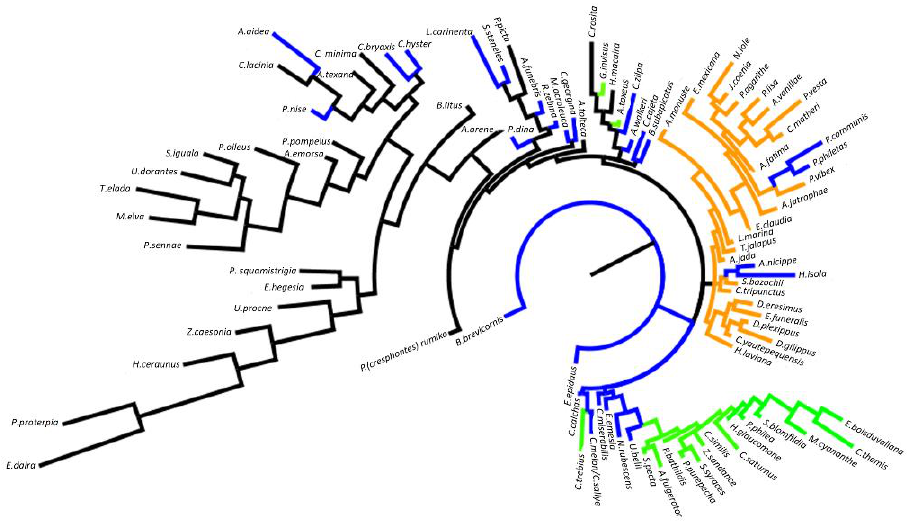
Figure 4. Cladistic tree based on presence / absence and relative abundances for every month and zone, and the degree of openness of the living environment for each species and humidity conditions. A pattern code was attributed to each species depending on the type of vegetation. Green is for species found only or preferably (more than 60%) in the forest (Zone W); blue is for species found only or preferably in zones covered by shrubs (Zones B and C); orange is for species found only or preferably in open areas (Zone A); black is for species which can be found in two or more of these categories with none exceeding 60% (generalist species). Three classes of characters—temporality, habitat specificity and abundance in each zone—were used to build this figure. We assumed that species placed on the center of the spiral are the most specialized ( Baronia brevicornis ) while those on the periphery ( Eurema daira and Pyrisitia proterpia ) are the most generalist